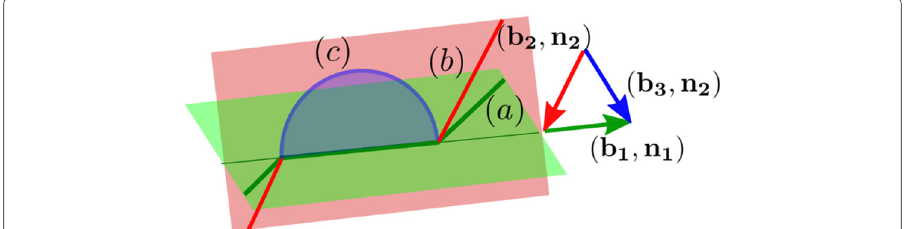
1 , n 1 ) and ( b 2 , n 2 ) interact and form a glissile junction acting like a Frank-Read source on slip system ( b 3 , n 2